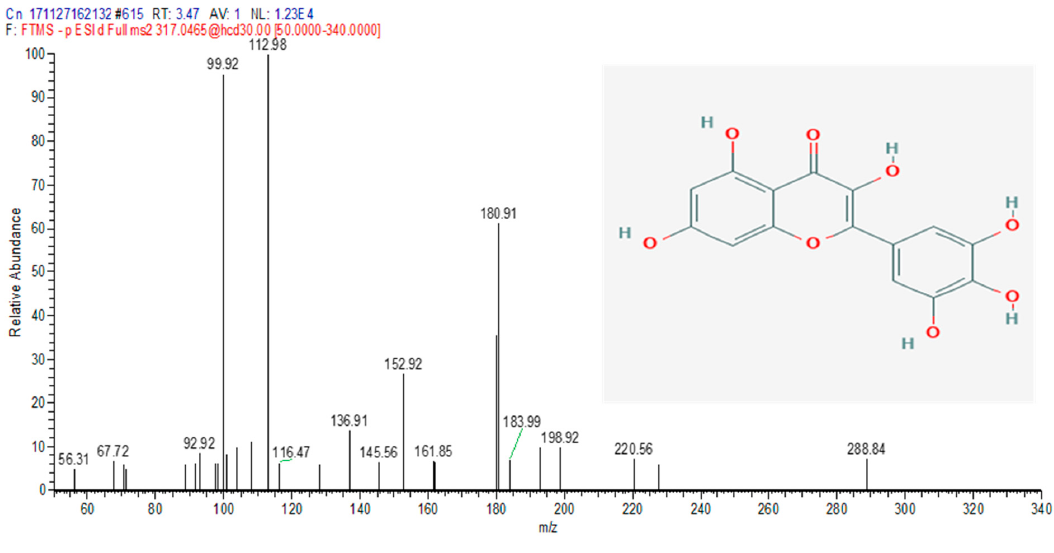
Figure 2. Myricetin.